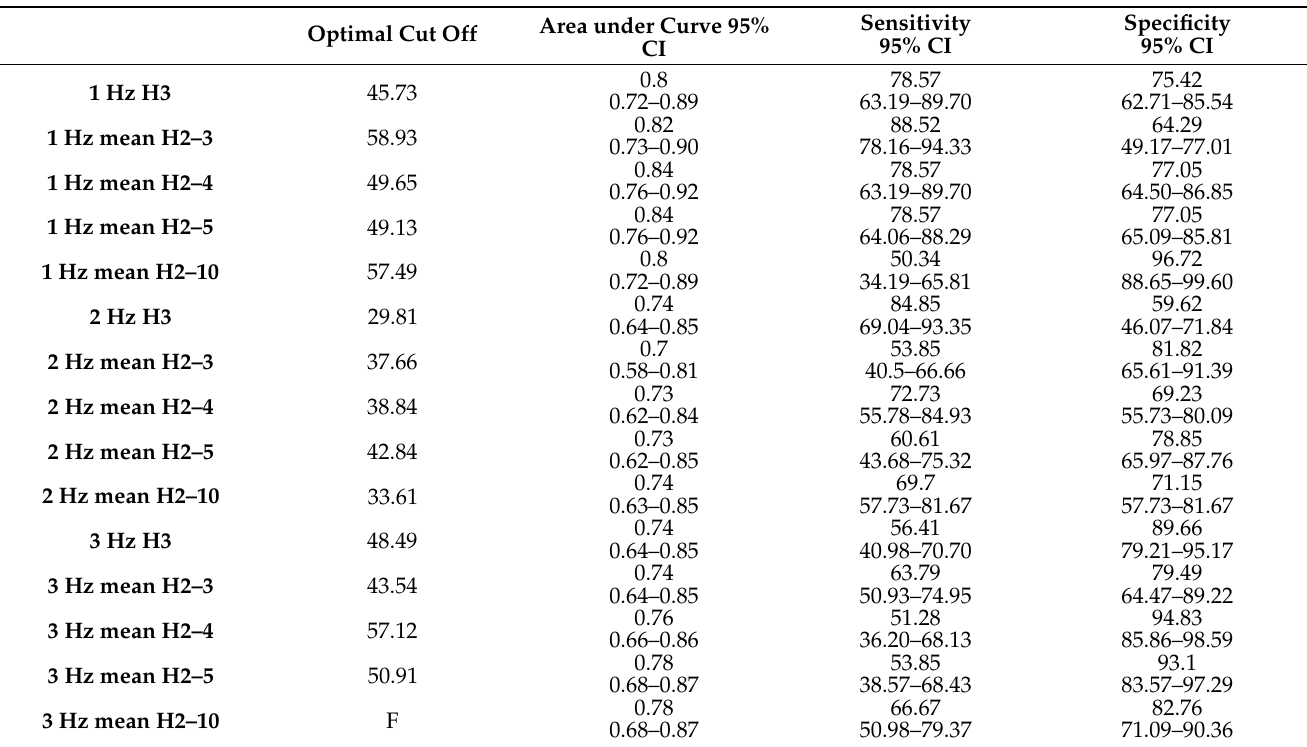
Figure 3. Receiver-operated characteristic (ROC) plots for HRDD at ( A ) 1 Hz, ( B ) 2 Hz, ( C ) 3 Hz in patients with painful diabetic neuropathy versus patients with painless diabetic neuropathy using stimulus response H3 (orange line), average of stimulus responses H2–4 (green line), average of stimulus responses H2–5 (blue line) and average of stimulus responses H2–10 (pink line). Table 3. Receiver-operated characteristic (ROC) analysis with area under the curve, optimal cut off and respective sensitivity and specificity with 95% confidence interval, for H-reflex stimuli responses at 1, 2 and 3 Hz in patients with painful and painless diabetic neuropathy. CI, confidence interval.